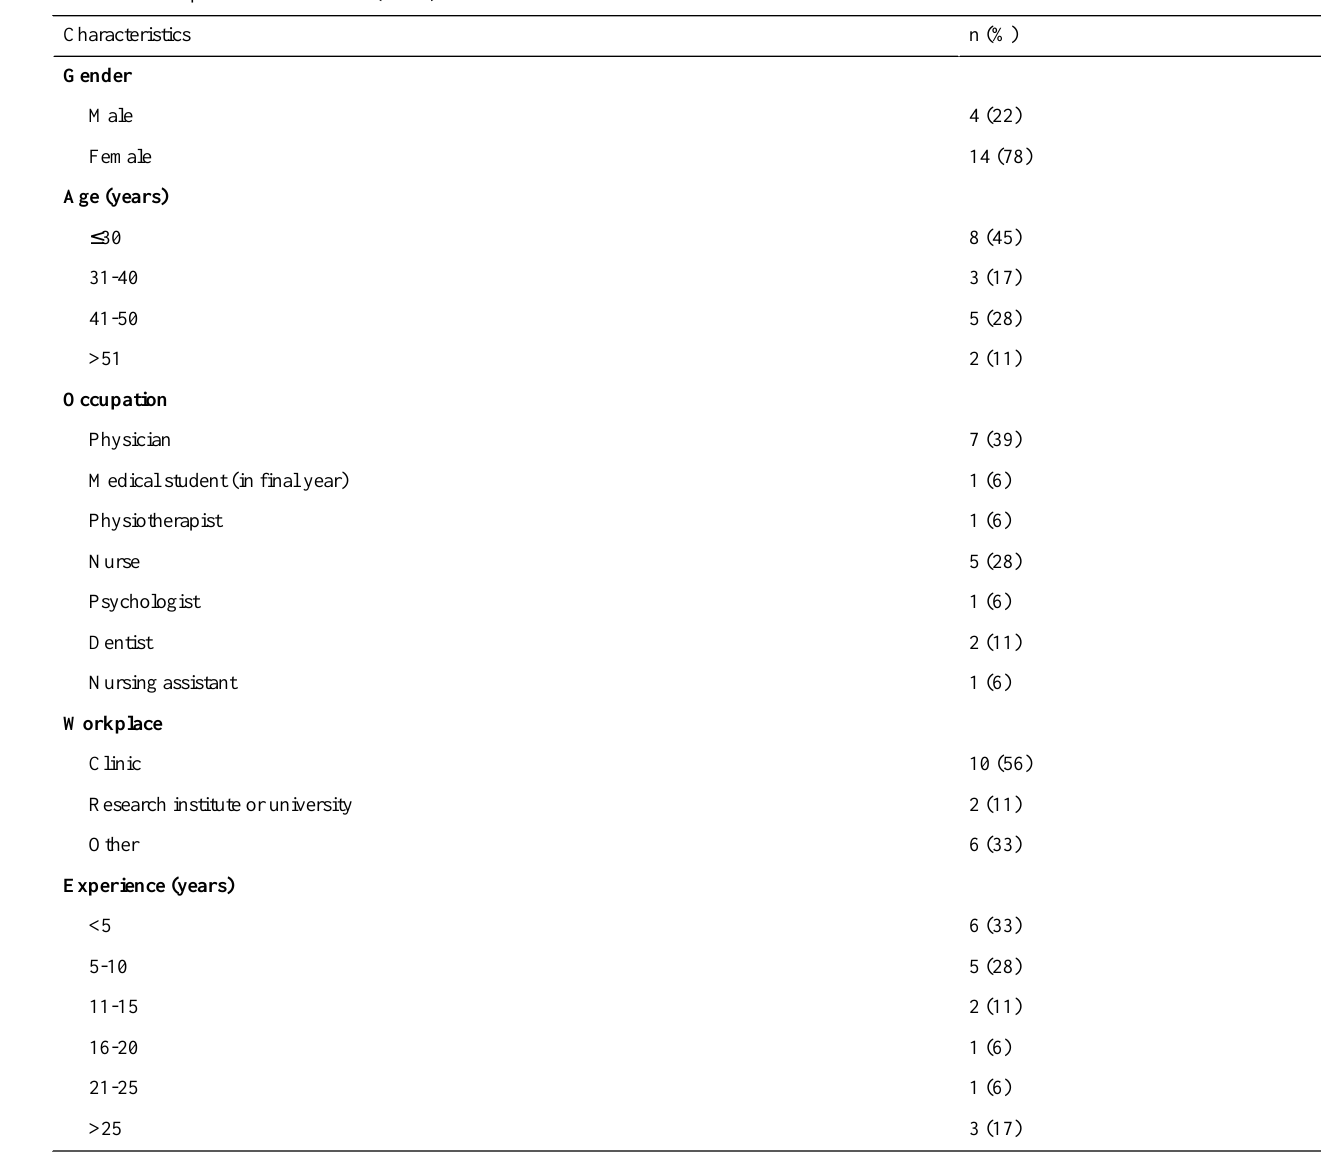
Table 4. Participants’characteristics